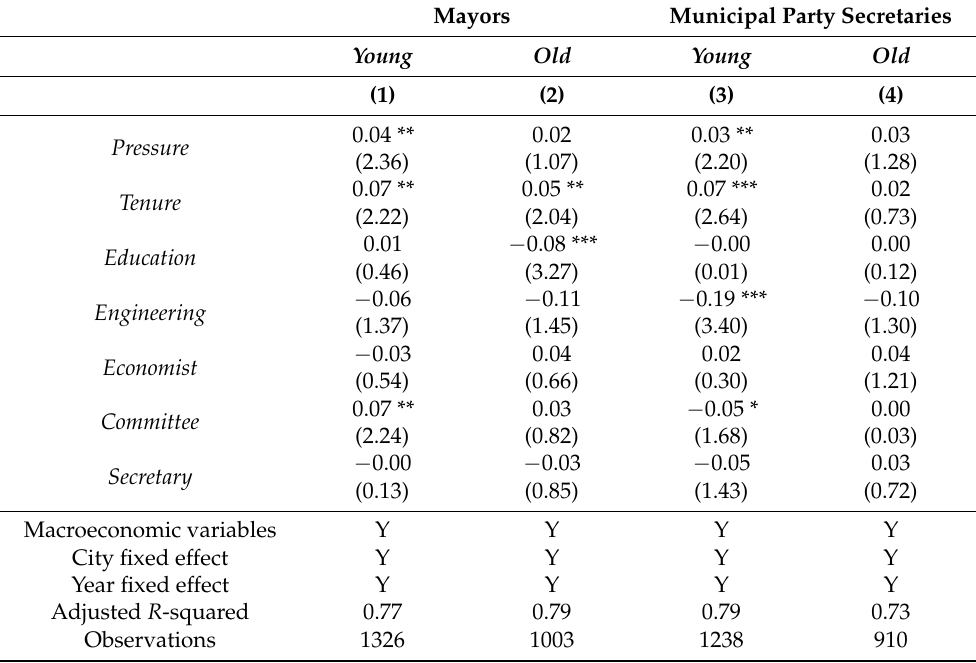
Table 4. Promotion pressures of different age group.